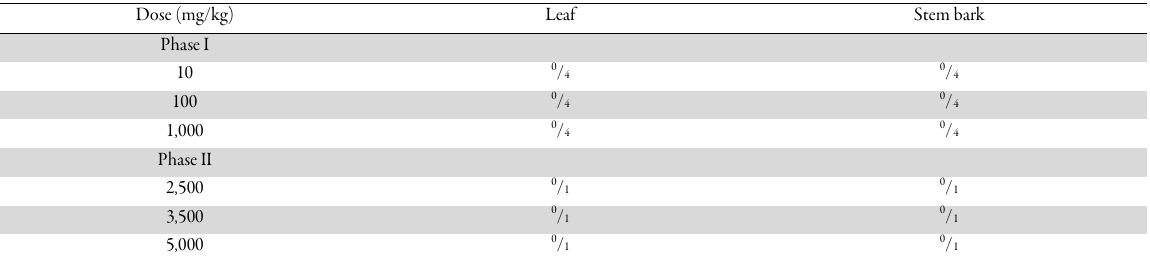
Table 1. Oral lethal dose of C. millenii leaf and stem bark in albino rats